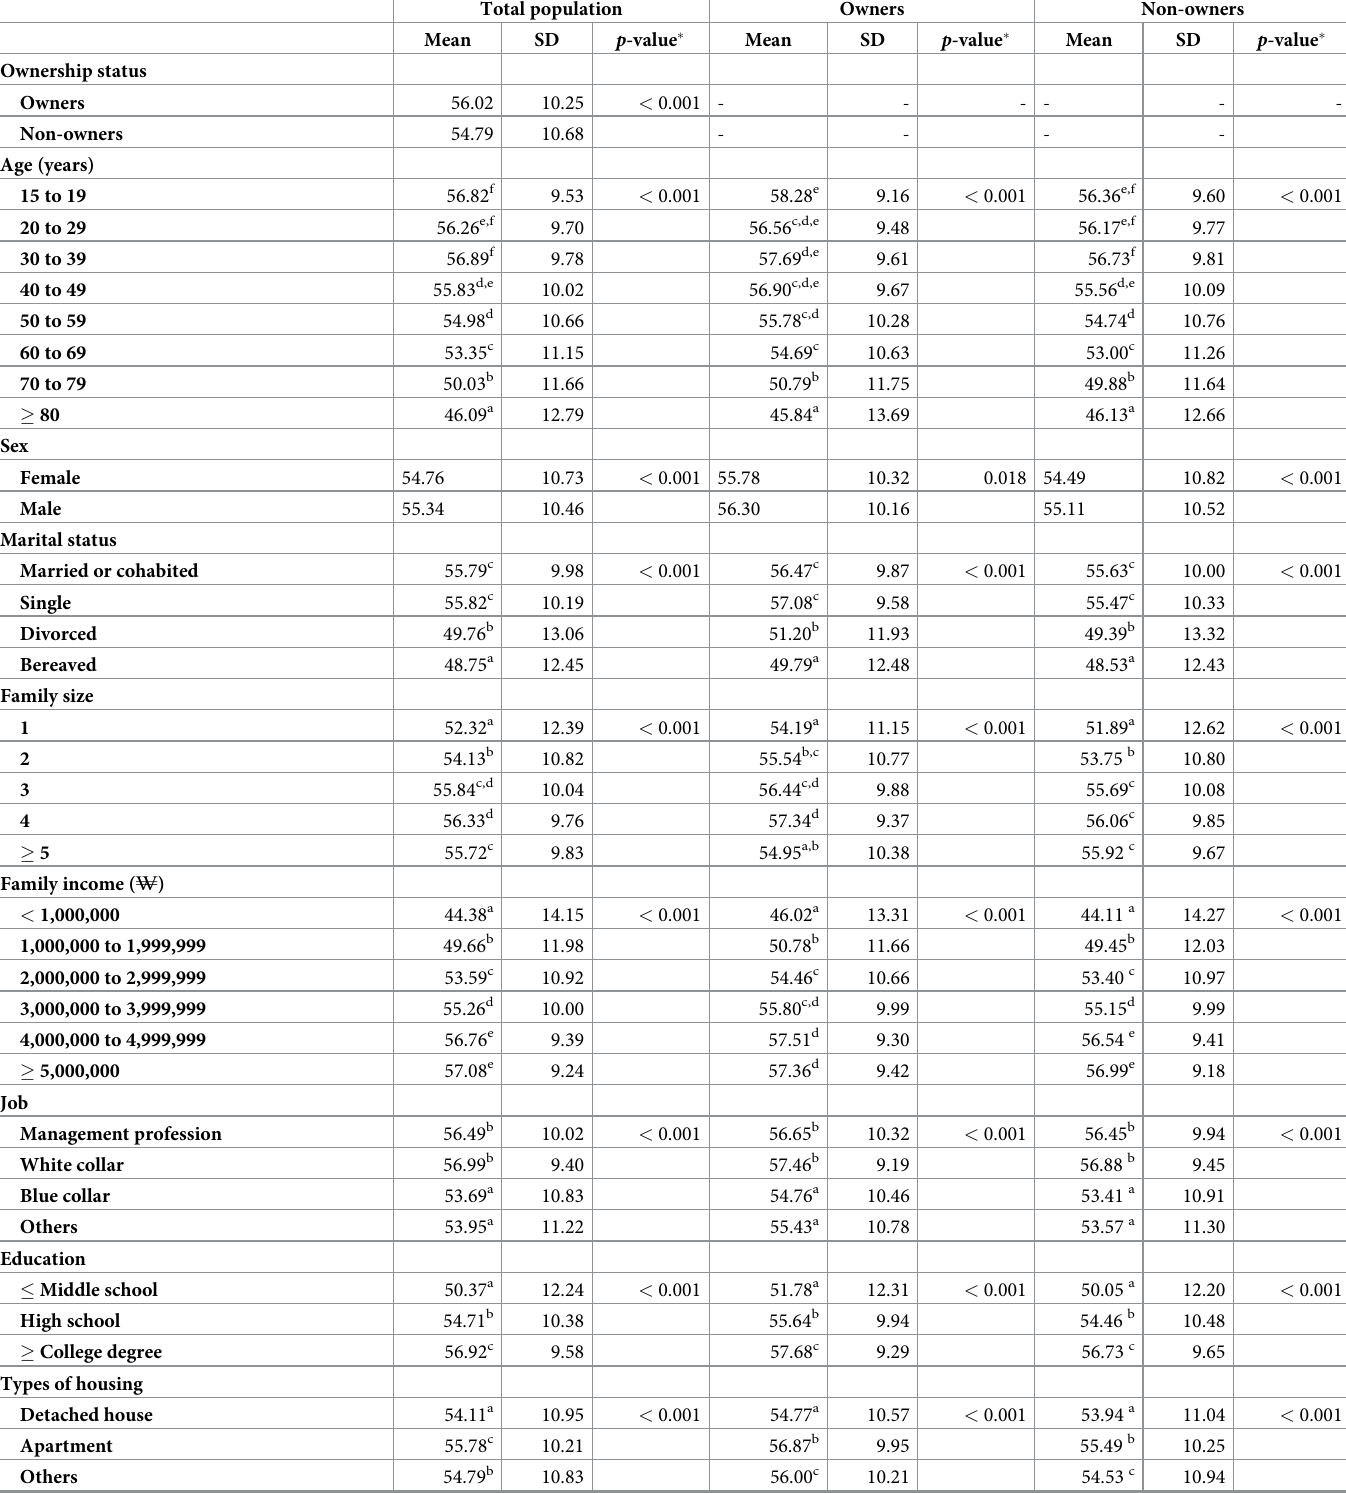
Table 2. Descriptive statistics, t-test, and ANOVA on overall life satisfaction by pet